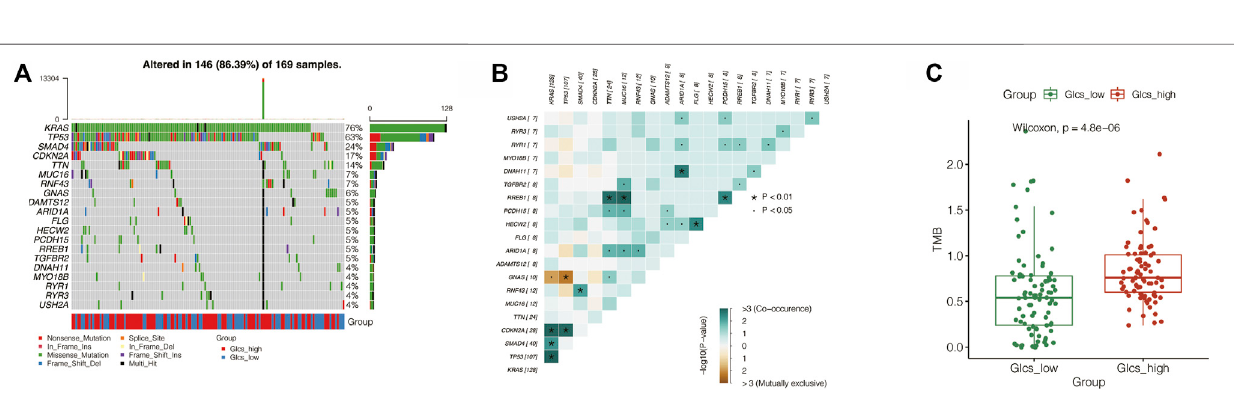
FIGURE 7 | Exploration of the relation between GLCS and tumor mutation. (A) Landscape of genetic mutations in PC patients. (B) Mutation symbiosis among the top mutation genes. (C) TMB were higher in the GLCS-high group.